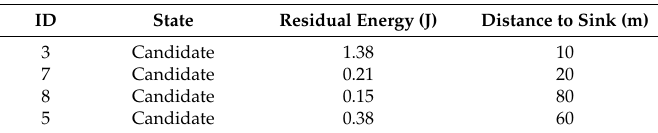
Table 1. Neighbor nodes of a candidate cluster